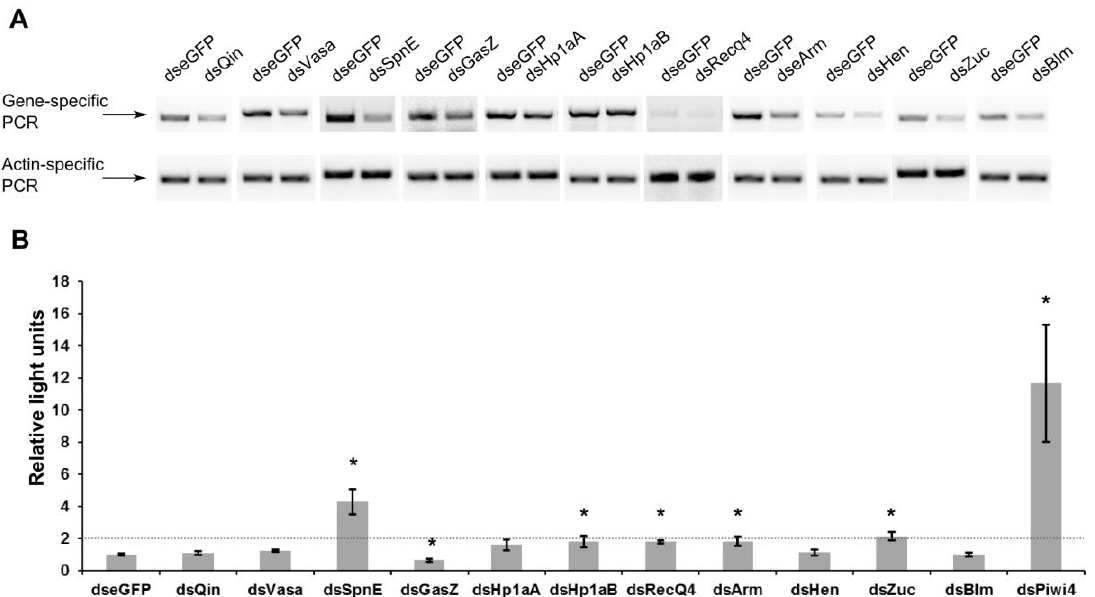
Figure 1. Effect of knock down of piRNA-related transcripts in Aag2 cells on SFV. Aag2 cells were transfected with unique, gene-specific dsRNAs against Piwi4 (positive controls) and potential piRNA pathway proteins. ( A ) Knock down of Ae. aegypti homologs of Drosophila transcripts of the piRNA pathway using dsRNA (dseGFP as control). Gene-specific primers were used to confirm silencing and an actin PCR product was used as internal control; ( B ) Aag2 cells transfected with gene specific dsRNAs (dsRNA against eGFP was used as negative control) were infected with FFLuc-expressing SFV (MOI 0.01) and cells lysed 48 hpi. FFLuc activities were measured and normalized to these from control cells (taken as 1); the dotted line represents the threshold level of at least a two-fold increase in luciferase levels. The mean values and standard error of three experiments conducted independently in triplicate are shown; * denotes p < 0.05 (according to Student’s t -test).